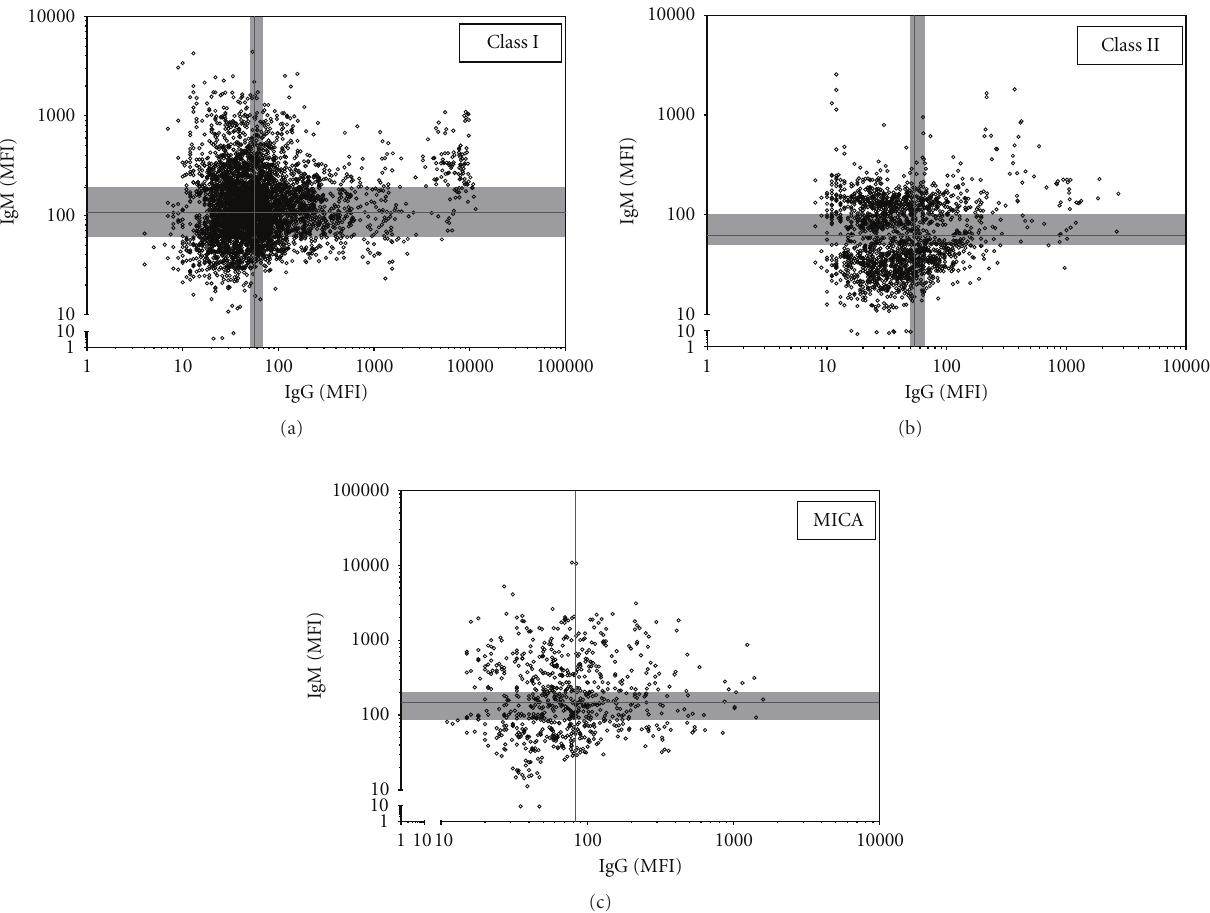
Figure 2: Correlation plots of IgM and IgG HLA class I (a), HLA class II (b), and MICA (c) antibodies after LTx. Grey lines represent the average background as detected in 27 unimmunized males (IgM) or as defined by the manufacturer (IgG). The background range of the individual beads is displayed by the grey area.